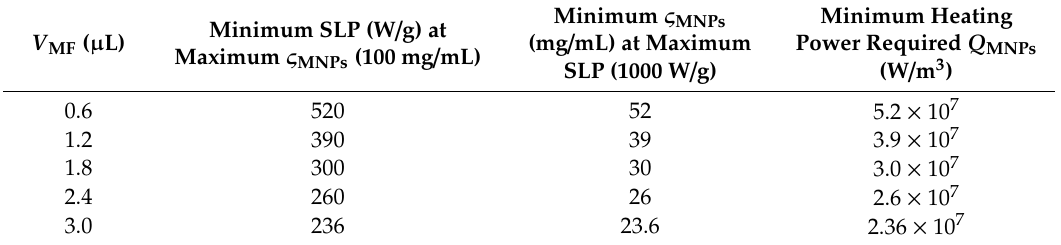
Figure 7. The temperature of the stimulation treatment region after time t = 25 s with T initial = 43 ◦ C for ( a ) V MF = 0.6 µ L; ( b ) V MF = 1.2 µ L; ( c ) V MF = 1.8 µ L; ( d ) V MF = 2.4 µ L; ( e ) V MF = 3.0 µ L; and ( f ) the minimum heating power Q MNPs required for safe execution of WMS (compared with other conditions). Table 3. The minimum values of SLP, ς MNPs and heating power Q MNPs values for safe WMS execution with di ff erent V MF